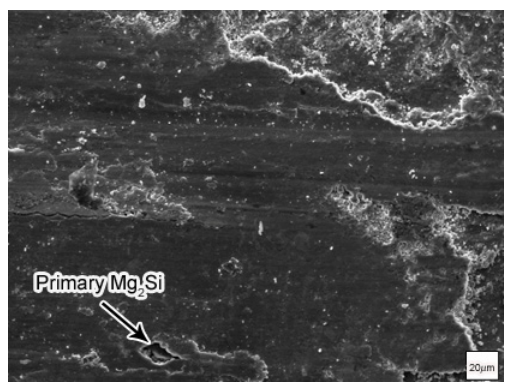
Figure 9. SEM of wear surfaces of Mg 2 Si–Al composite fabricated by using semi-solid extrusion with isothermal heat treatment holding time of 160 min, with a sliding velocity of 1000 r / min.